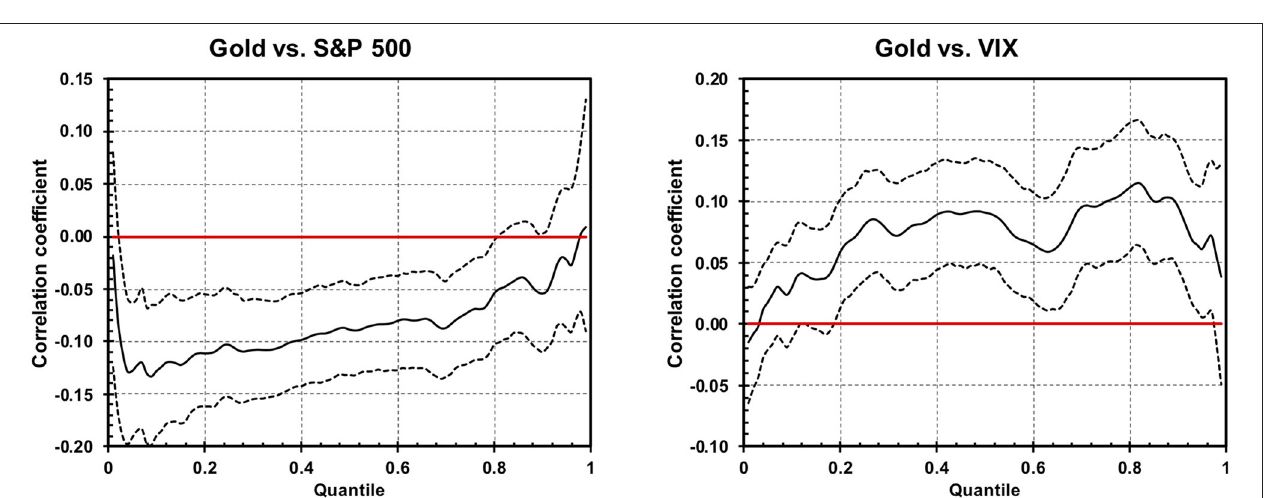
FIGURE 2 | Quantile correlations for Bitcoin. (Left) Quantile correlations between Bitcoin and the S&P 500 index. The quantiles on the x -axis are with respect to the S&P 500 index. The low quantiles show the extreme negative events. Black bold curve shows the mean value of 1,000 bootstrapped estimates. The dashed curves show the 90 % confidence intervals based on the bootstrapped estimates. (Right) Quantile correlations between Bitcoin and the VIX index. The quantiles on the x -axis are with respect to the VIX index. The high quantiles show the periods of high uncertainty. The other notation holds.